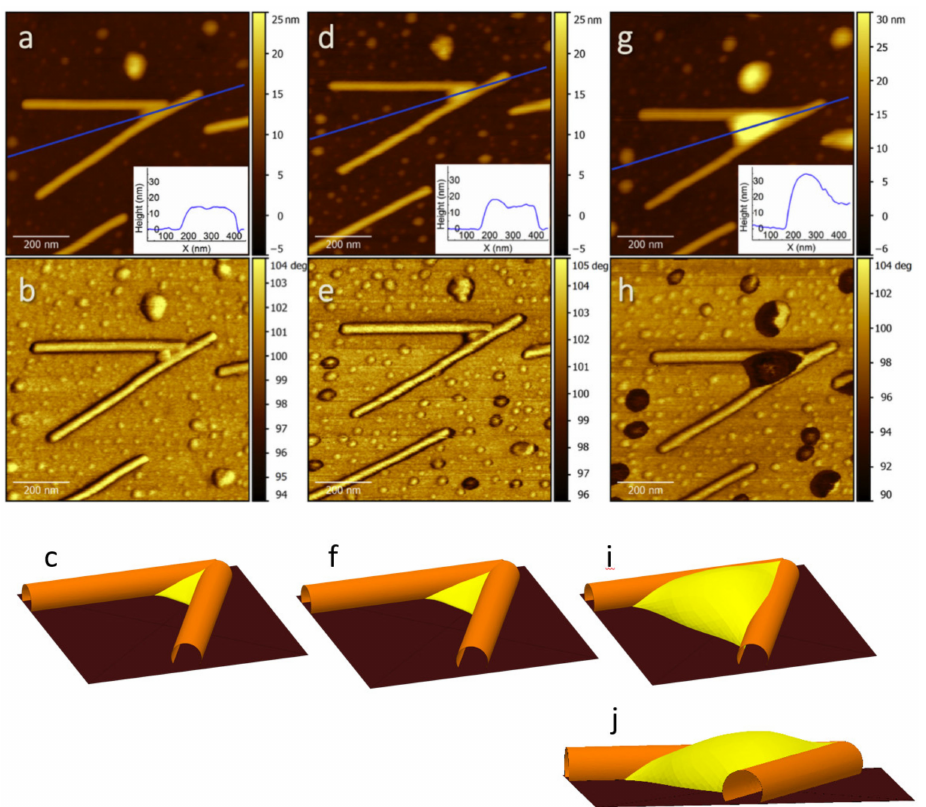
Figure 3. AFM topographic details showing TMV particles in a V-shaped arrangement ( a , d , g ), and corresponding Φ 2 images ( b , e , h ). Surface Evolver simulations were obtained by increasing pressure from negative ( c ), to zero ( f ), to positive ( i , j ) values. AFM data correspond to RH = 56% ( a , b ), 76% ( d , e ), and >100% ( g , h ). ( a , d , g , inset) Topographic profiles correspond to the blue lines in ( a , d , g ). A side view of ( i ) is shown in ( j